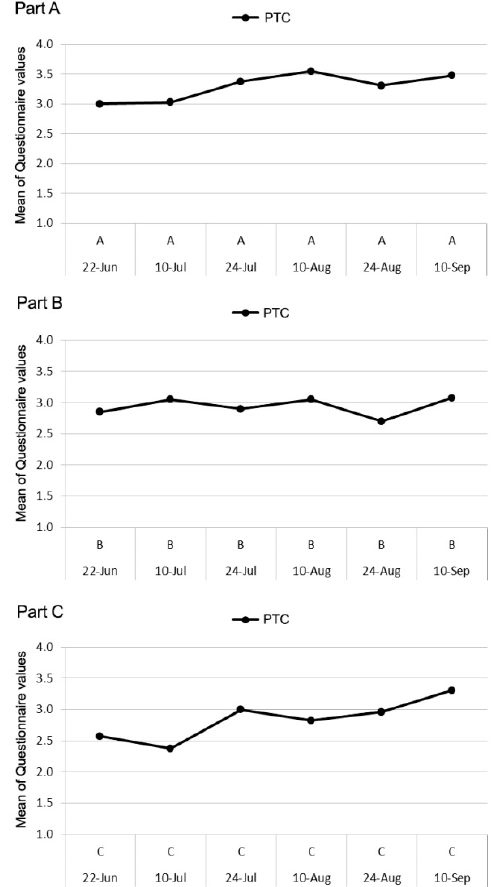
Figure 7. The average data for questionnaire data titled PTC at each three intersections A, B and C during six days.